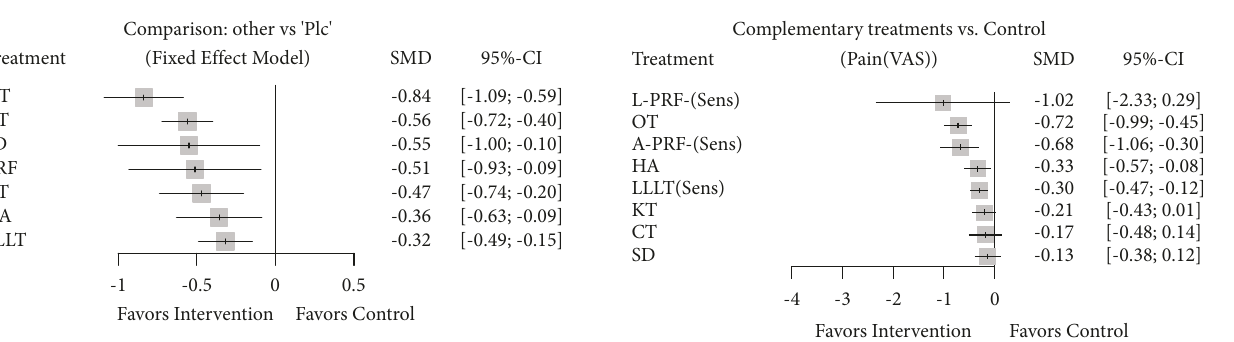
Figure 12: Forest plot comparing different complementary in- terventions for reducing late pain after third molar surgery after sensitivity analysis. PRF: platelet-rich fibrin; SD: surgical drainage; CT: cryotherapy; HA: hyaluronic acid; KT: Kinesio taping; LLLT: low-level laser therapy; OT: ozone therapy; Plc: